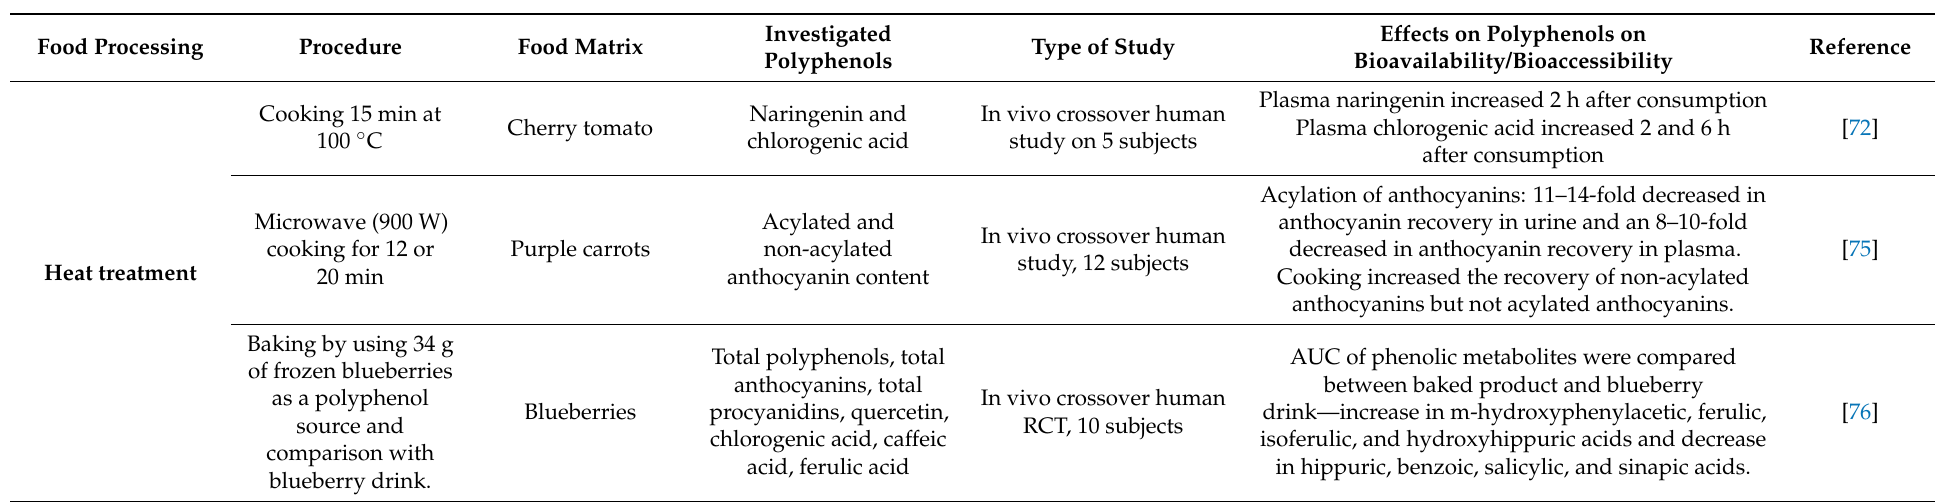
Table A2. Overview of studies investigating the food-processing effects on polyphenols